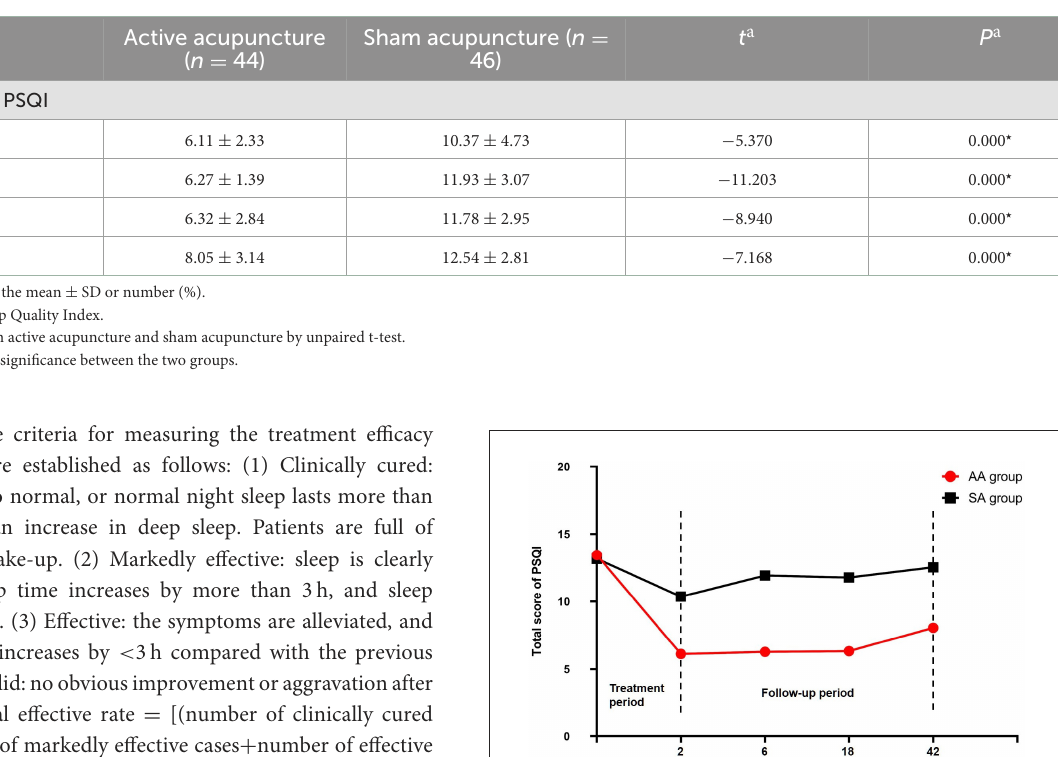
TABLE 3 Primary outcomes.